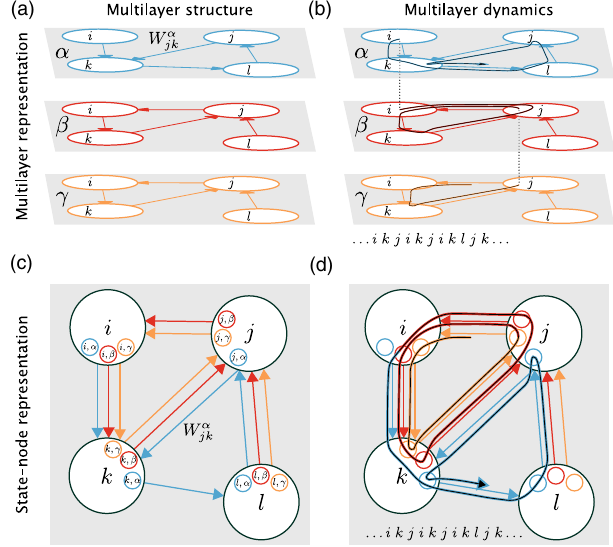
FIG. 1. Modular flow on the benchmark multilayer network. (a) A schematic multilayer network with physical nodes i , j , k , and l , and three layers α , β , and γ in blue, red, and orange, respectively. The physical nodes in each layer are connected with intralayer link weights W α jk . (b) A random walker on the multi- layer network moving between the physical nodes in each layer, twice relaxing the layer constraint and following a link from the physical node in any layer. (c) The three layers represented as a multiplex network with physical nodes in black and state nodes i; α in blue, red, and orange. (d) A random walker on the multiplex network moving between the state nodes. While the random walker moves according to the weights between the state nodes, only the physical nodes are considered to be observables, as illustrated by the sequence of physical nodes that the random walker has visited. When the random walker moves along links of the blue layer, it is trapped in the lower-right triangle. When the random walker moves along links of the red or orange layer, it is trapped in the upper-left triangle. As a consequence, the multi- layer network has two overlapping modules with respect to